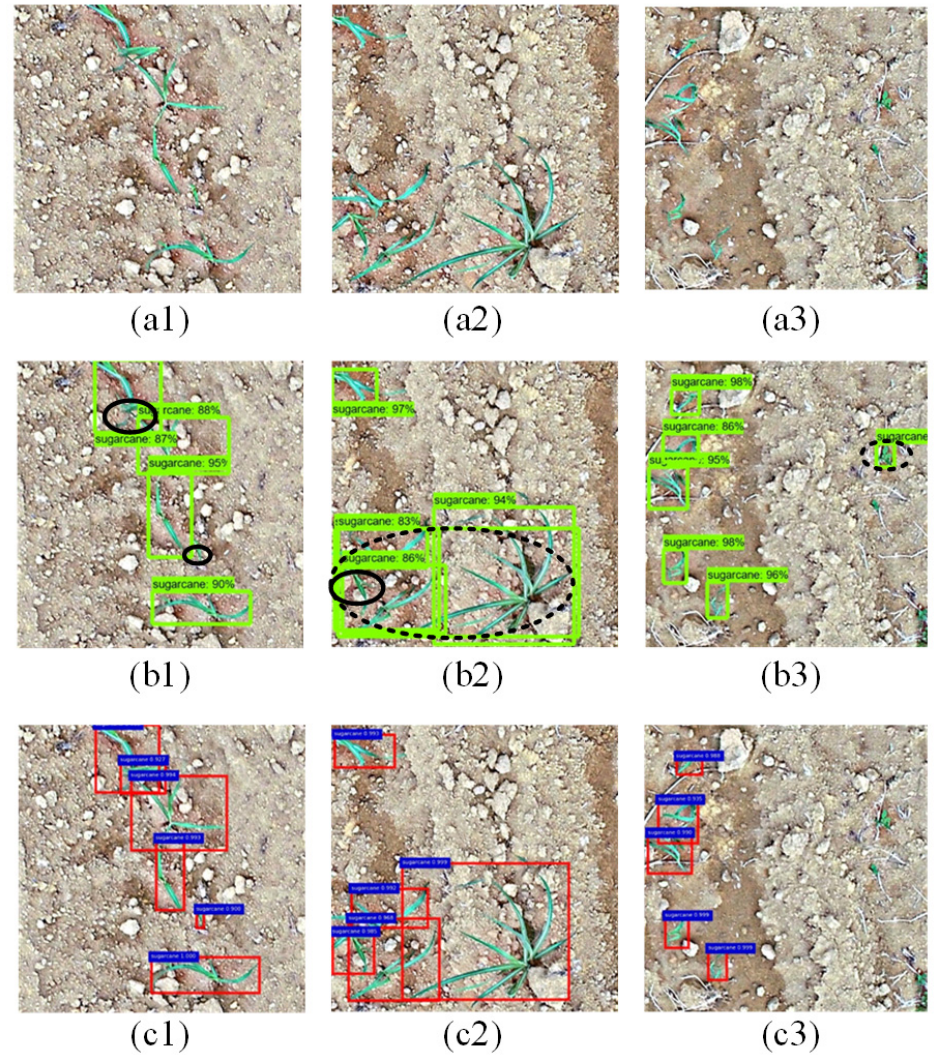
Figure 9. Comparison of sub-images test results. Subfigure ( a1 – a3 ) represent the test images, sub- figure ( b1 – b3 ) represent the detection results of the test images in the original Faster R-CNN, and subfigure ( c1 – c3 ) represent the detection results of the test images in the improved Faster R-CNN. The green rectangle box represents the detection result of the original Faster R-CNN, the solid black ellipse box represents the missed detection, and the dashed black ellipse box represents the false detection. The red rectangle box represents the detection result of the improved Faster